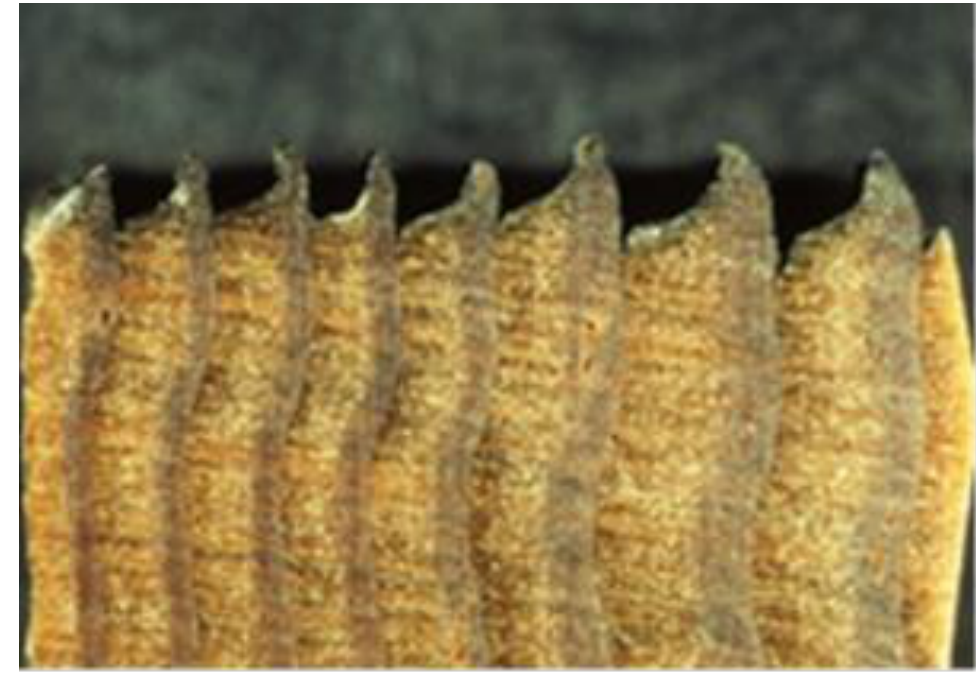
Figure 9. Rough surface of wood after